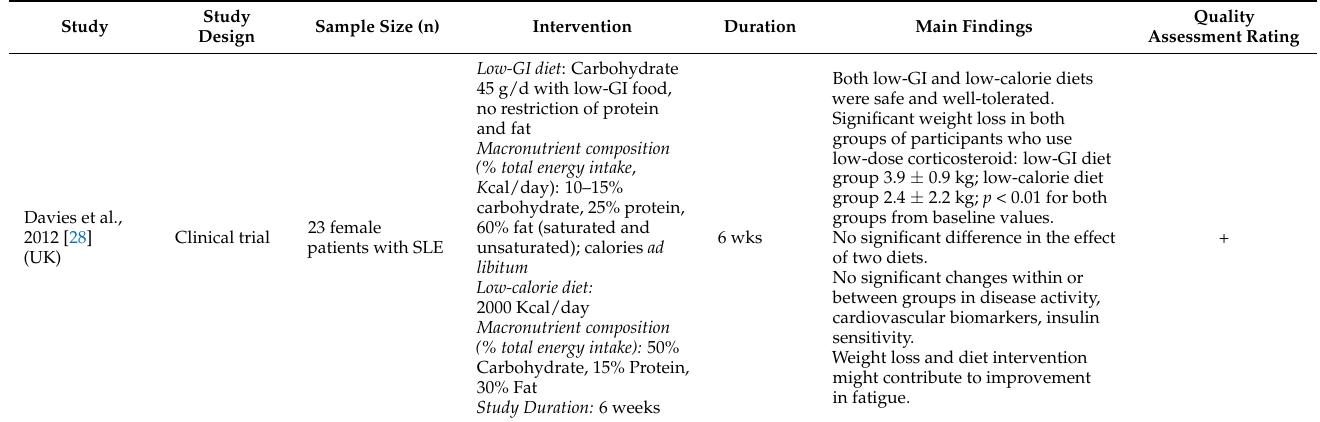
Table 5. Characteristics of included studies on the effect of specific dietary